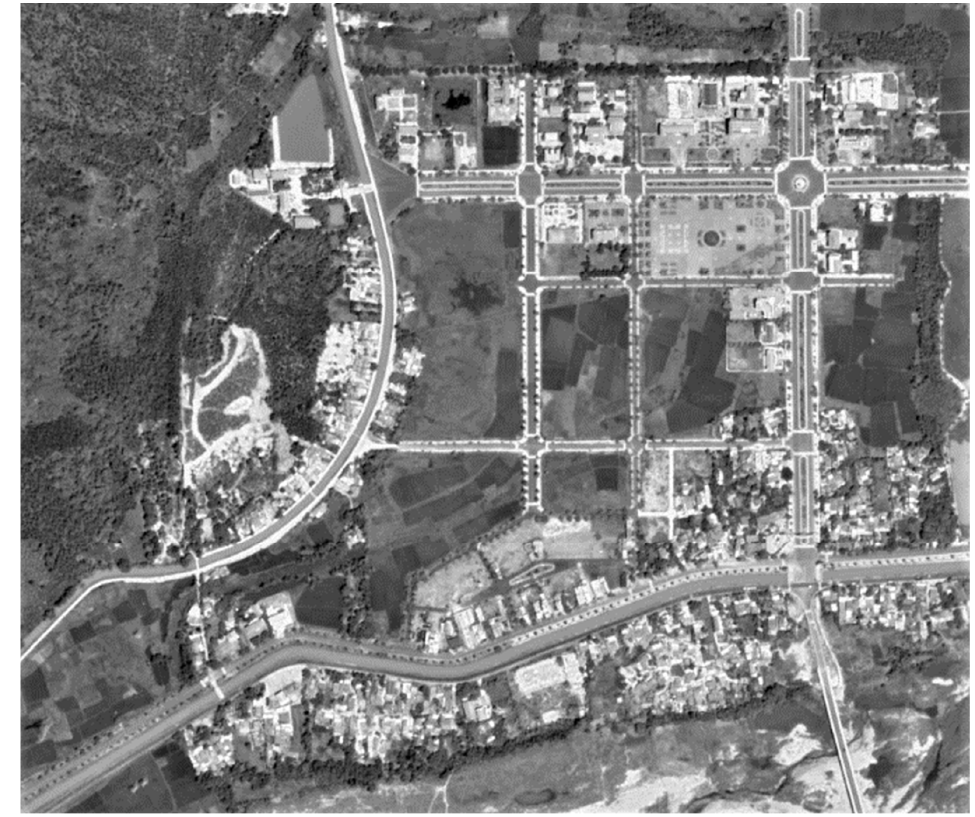
Figure 7. Satellite Image of H ồ Citadel (Adapted from Google Earth by Noseworthy).